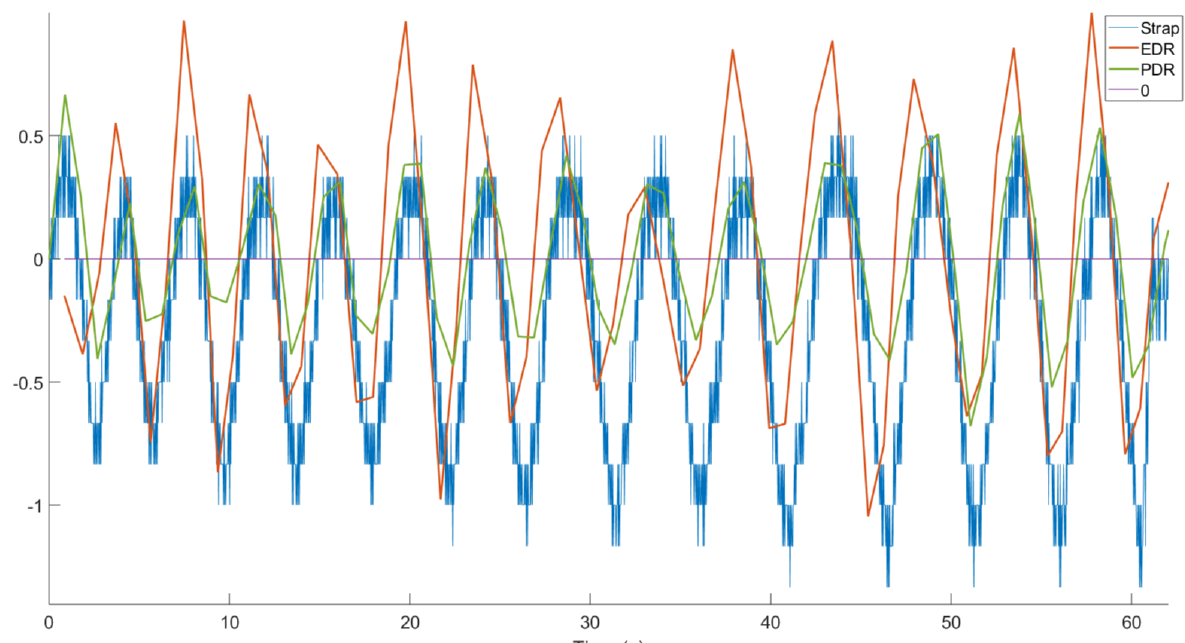
Figure 16. PDR (green) processed from tracheal sounds and ECG-Derived Respiration (EDR) (red) processed from ECG and the thoracic strap signal (blue). Their positive (negative) slopes indicate inspiration (expiration).